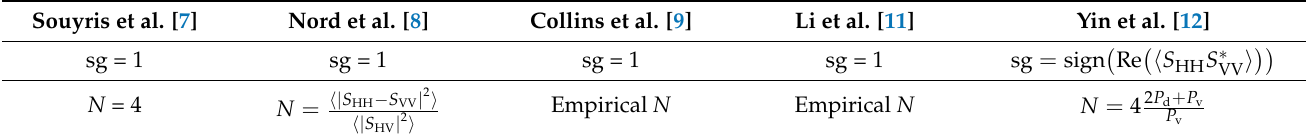
Table 1. Parameters of the reconstruction